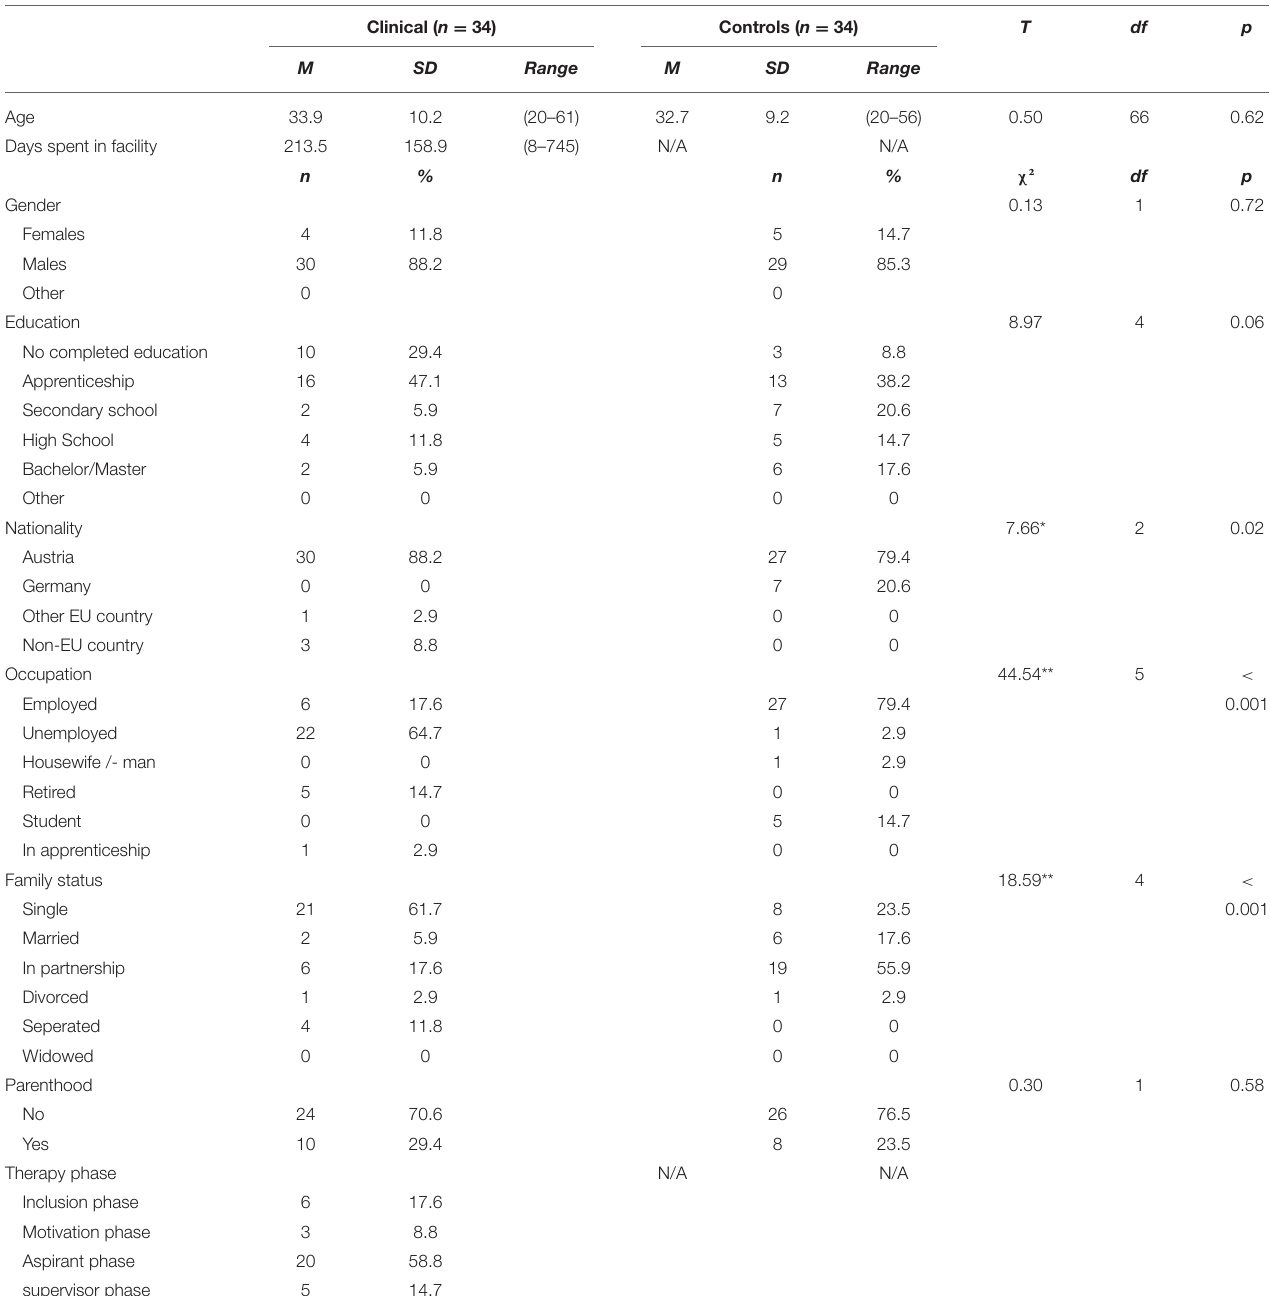
TABLE 1 | Sociodemographic data with group